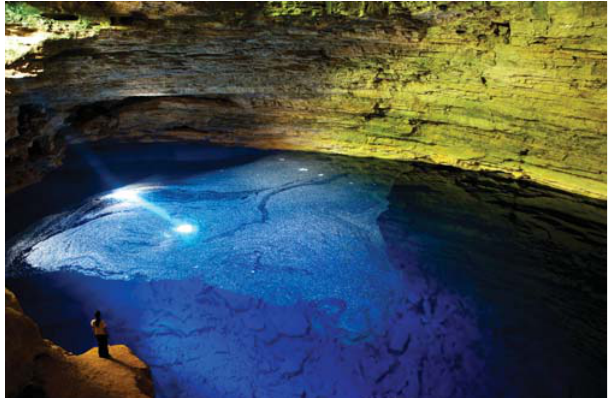
Fig. 15. View of the type-locality of Rhamdiopsis krugi , Poço Encantado cave (12º56’37’’S 41º06’05’’W), Municipality of Itaetê, Bahia, northeastern Brazil, taken in 2008. Courtesy of Adriano